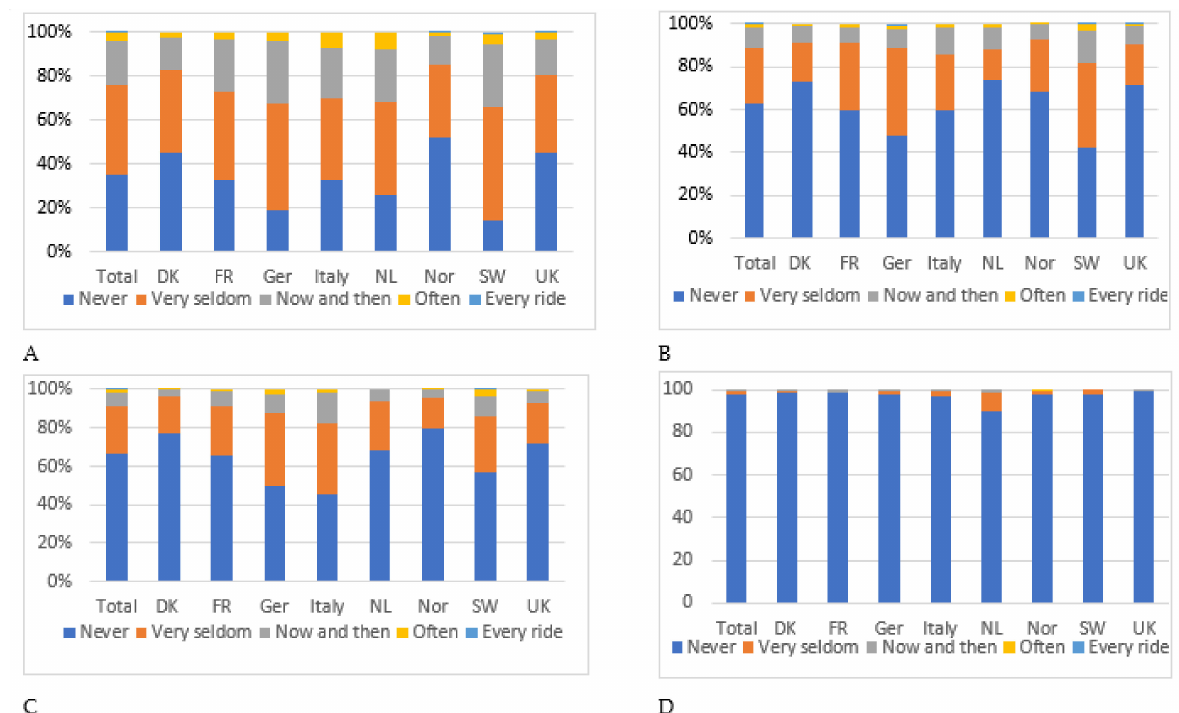
Figure 3. Responses to the question, “How often have the following scenarios occurred when riding unofficial trails?”. ( A ) Other users make negative comments. ( B ) Other users block the trail and have a discussion with me. ( C ) Discussion with landowner or manager. ( D ) Issued a fine/penalty.